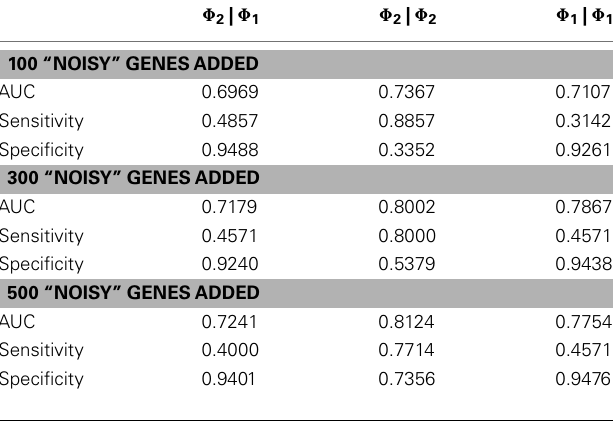
Table 2 | Comparison of methods with added noise.